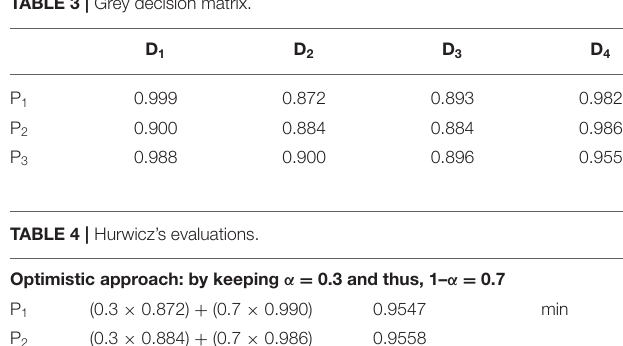
TABLE 3 | Grey decision matrix.